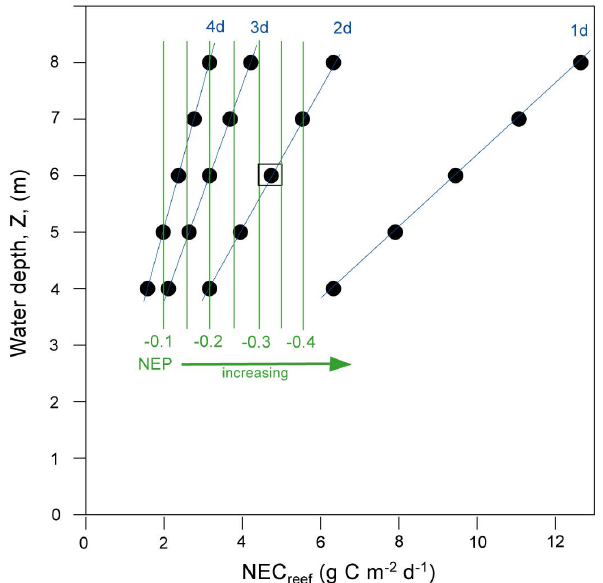
Fig. 6. Annual rates of NEC reef (gCaCO 3 m − 2 d − 1 ) plotted against water depth (m) using the alkalinity anomaly-water mass residence technique, and mass balance. Different water residence times ( τ) of 1 to 4 days are plotted with isolines in blue. NEP reef (gCm − 2 d − 1 ; green lines) are superimposed as isolines in green with negative val- ues indicating net autotrophy. The most appropriate water depth of 6m and residence time of 2 days for the Bermuda reef is shown by the